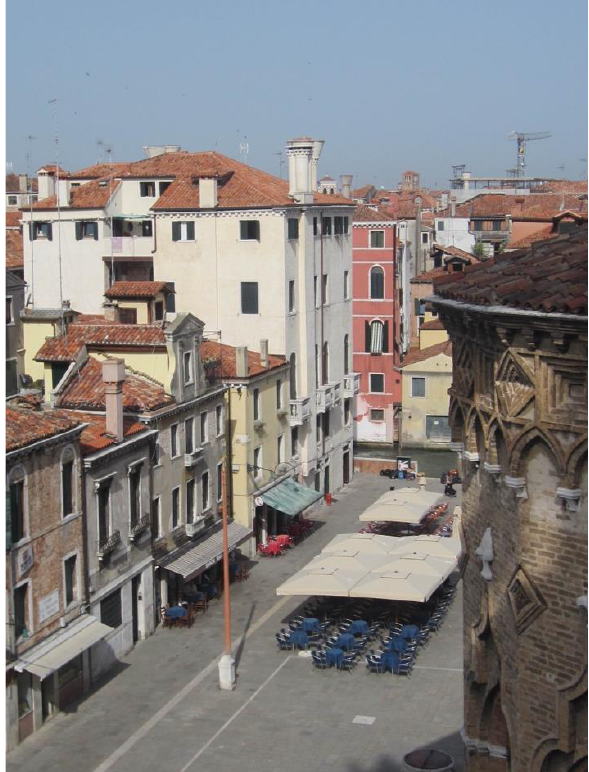
Figure 5. View from above of Campo San Giovanni e Paolo with seating and tables for bars and